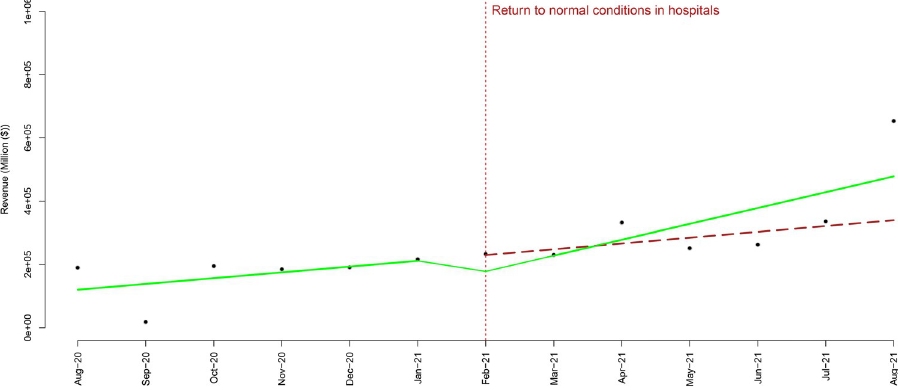
Fig 2. The temporal trend of the revenue rate after return to normal conditions in hospitals.